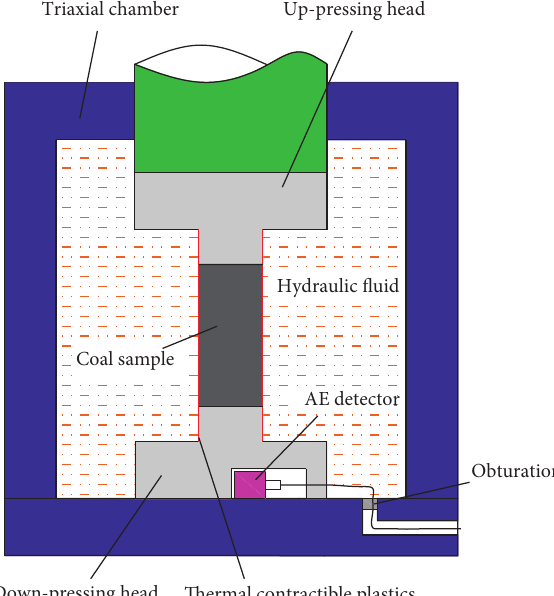
Figure 4: AE detector placed in a test head.